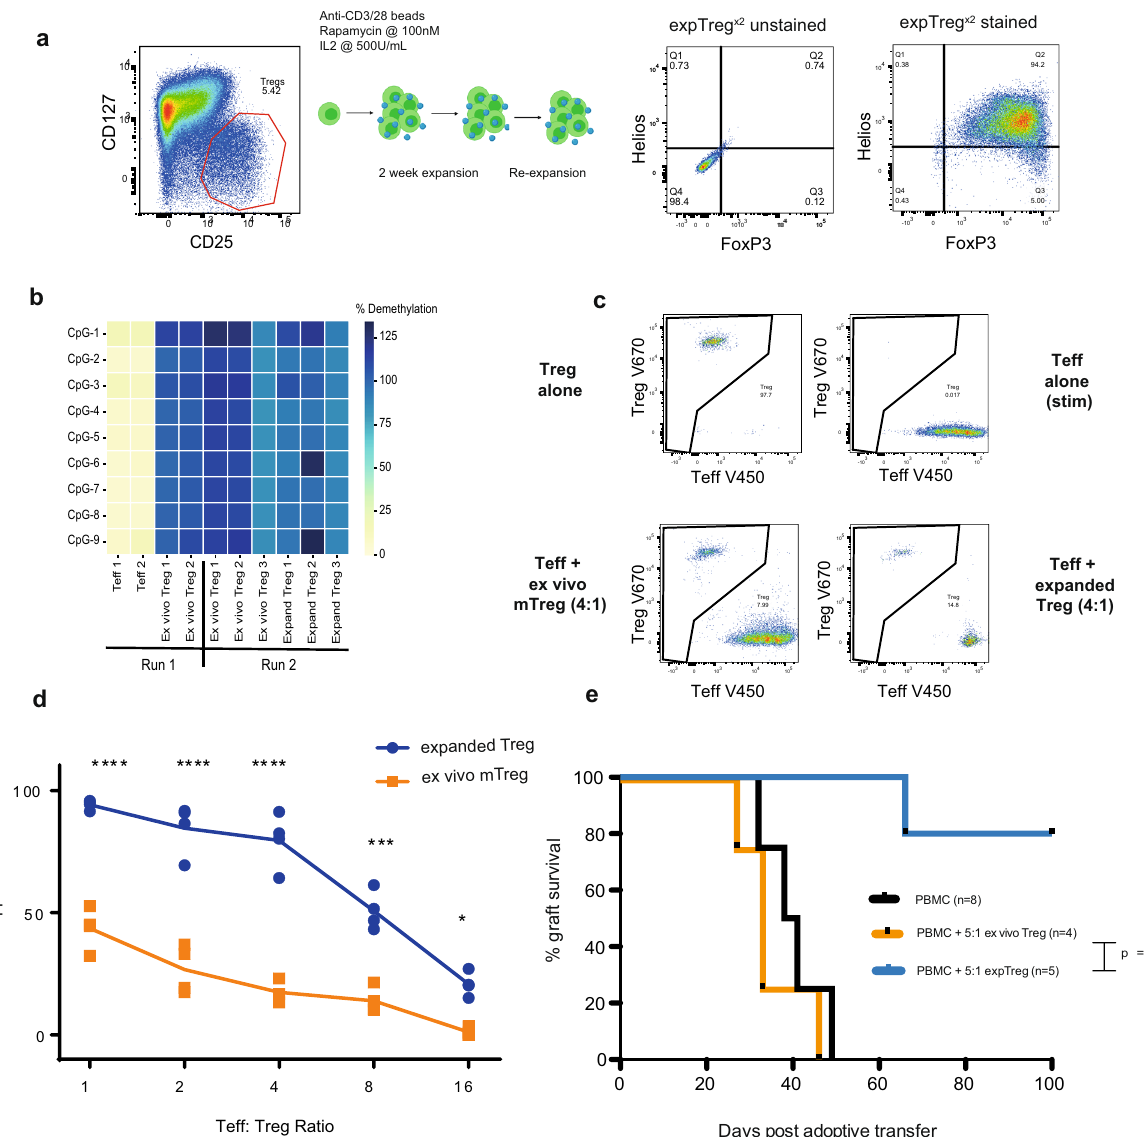
Fig. 1 Therapeutically expanded human Tregs show enhanced suppressive function. a Flow-sorted human Tregs (CD3 + CD4 + CD25 hi CD127 lo ) were expanded with anti-CD3/CD28 beads in presence of high-dose IL-2 (500 U/mL) and low-dose rapamycin (100 nM) in 2-week cycles. Representative plots showing Helios/FoxP3 expression on resting expTreg after two cycles of expansion (expTreg x2 ), gated on live CD4 + T cells. b FOXP3 TSDR demethylation of fl ow-sorted human Tregs (CD3 + CD4 + CD25 hi CD127 lo ) vs. T effectors (Teff), run 1 ( n = 2) and ex vivo Treg vs. expanded Treg (expTregs), run 2 ( n = 3, 2 female and 1 male donor). c Suppression assay labelling strategy: Flow-sorted ex vivo CD3 + CD4 + CD25 hi CD127 lo CD45RA − memory Tregs (mTreg) or resting expTreg x2 were labelled with cell division dye V670 (top left plot), and sorted pan T (CD3 + ) effector cells with proliferation dye V450 (top right plot), then cultured separately or together (bottom left — ex vivo Tregs; bottom right, expTreg ×2 ) in an in vitro Treg suppression assay ±anti-CD3/ CD28 stimulation. d Summary showing the suppressive function of ex vivo mTregs (orange) vs. expTreg ×2 (blue) from four donors at various Teff:Treg ratios. Line shows the mean percent suppression. n = cells from individual donors, analysed in independent experiments. Compared with ex vivo mTregs, expTreg ×2 were more suppressive at all ratios tested (Two-way ANOVA with Bonferroni multiple testing correction * P < 0.05, ** P < 0.01, *** P < 0.001, **** P < 0.0001). e In vivo skin graft model, in which mice received a skin graft plus 5 × 10 6 allogeneic PBMCs together with 1 × 10 6 ex vivo (orange) Tregs or 1 × 10 6 resting expTregs ×2 (blue). Data show a Kaplan – Meier survival curve of graft survival (Log-rank test, p -value as